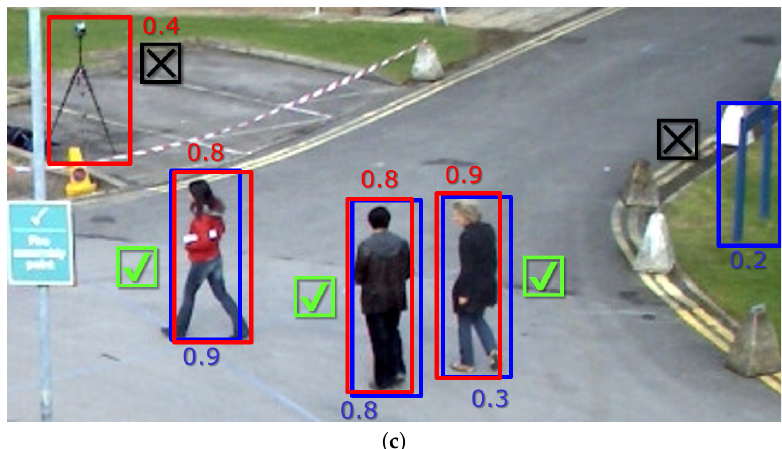
Figure 3. Visual example of the correlation between two cameras: ( a ) Camera 1 (camera under analysis) and detections in red color and ( b ) Camera 2 and detections in blue color. ( c ) Camera under analysis (Camera 1) with original red detections D 1 and transferred blue ones D 2 . In this case, the optimal thresholds according to the correlation between both cameras are 0.4 > τ 1,2 respectively. All the images are cropped versions for visualization purposes.